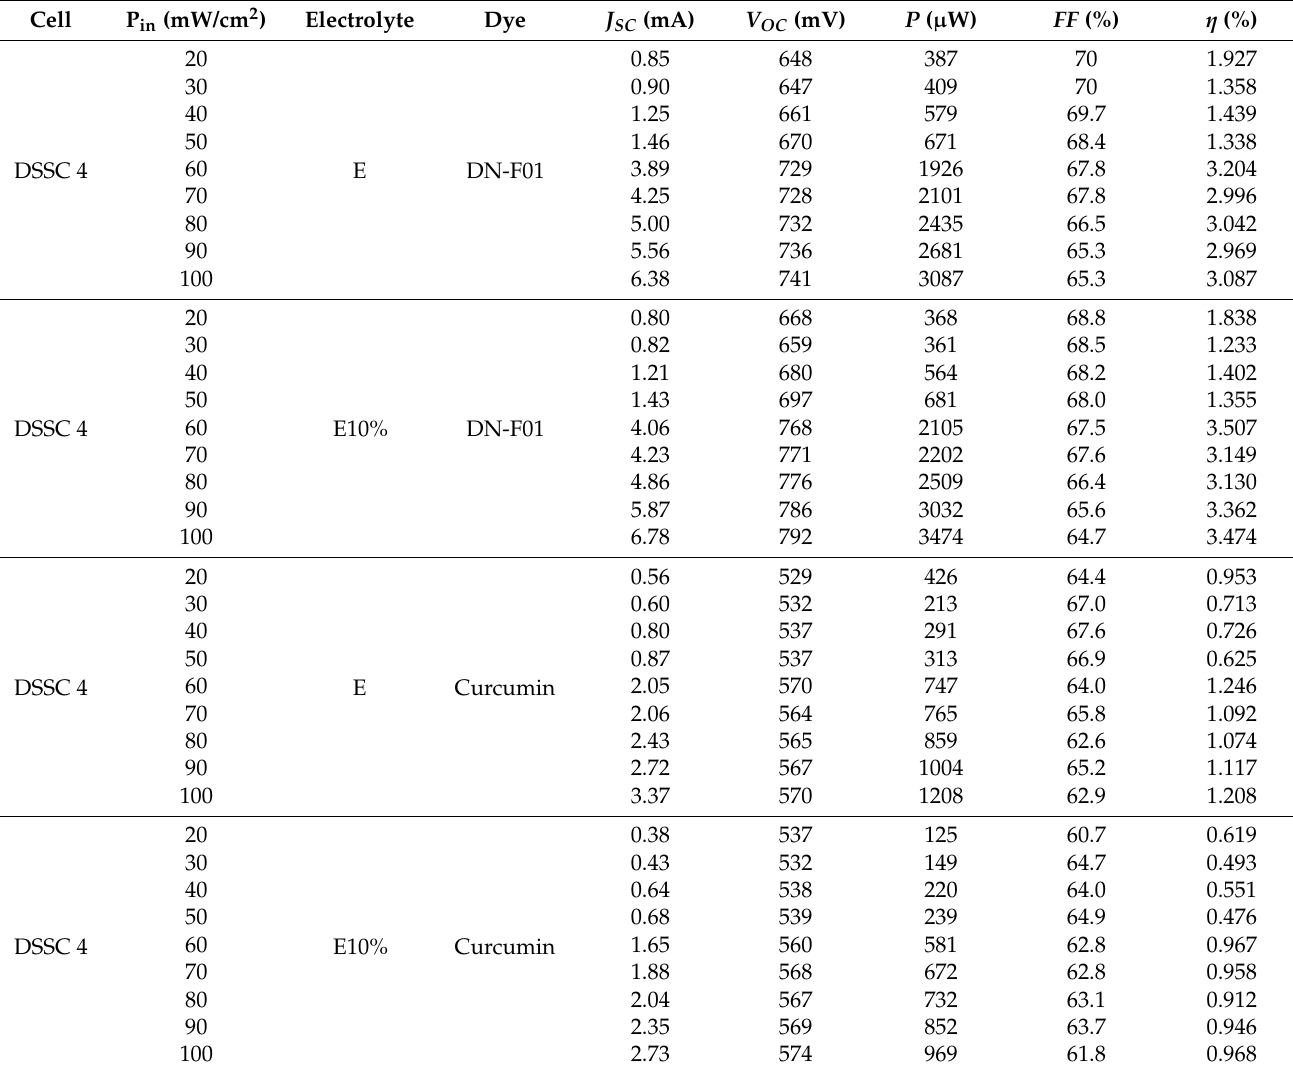
Table 2. The photovoltaic parameters of DSSC4 under different illumination